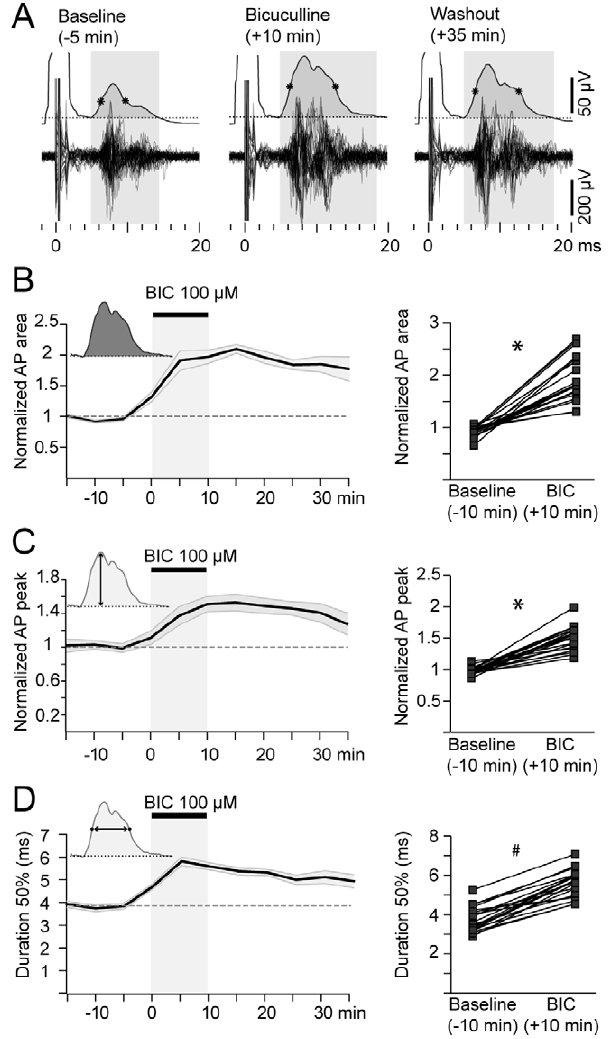
Figure 7. Intrastriatal bicuculline increases the amplitude and duration of striatal output. A. Representative multiunitary response to cortical stimulation before, during and after delivering bicuculline into the striatum. The top trace corresponds to the rectified, smoothed and averaged action potential activity of 20 individual trials. Dotted line reflects 3 SD of multiunitary activity during 100 ms prior to stimulation onset (400 m A). Note the increase in the amplitude and duration of the response after bicuculline. Similar results were obtained for 300 m A cortical stimulation. B–D. Effect of bicuculline on the area ( B ), amplitude ( C ) and duration ( D ) of multiunitary action potential responses of 20 recording sites at the hot spot from 3 different experiments. * p , 0.0001, Wilcoxon paired test. # p , 0.0001 Student’s paired t test.